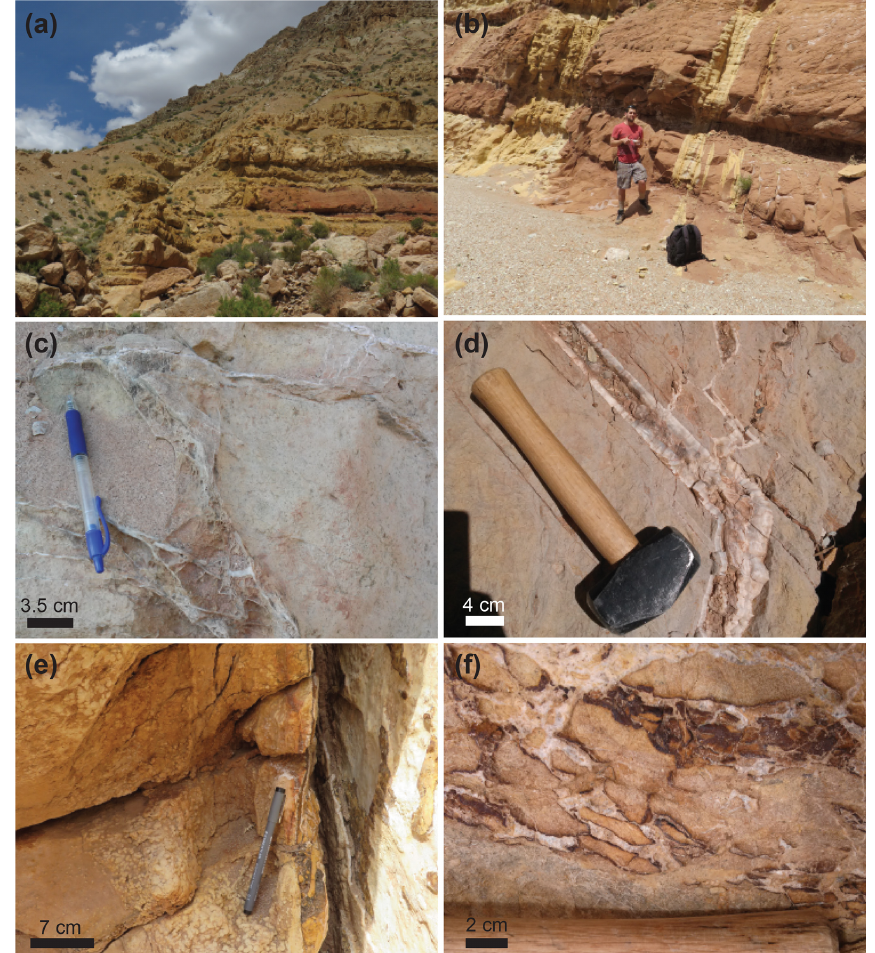
Figure 3. (a) Looking north along the Hurricane fault trace with colluvium in the hanging wall offset against the Permian Queantoweap Sandstone. Note the bleaching along the fault trace and in horizontal strata of the Queantoweap Sandstone. (b) Decimeter- to meter-scale bleached fractures cutting Queantoweap Sandstone (Jace Michael Koger used for scale). (c) Boxwork sparry calcite veins. (d) Laminated, centimeter-scale calcite vein with minor intergrown hematite cutting cherty limestone host rock. (e) Laminated calcite vein with minor hematite cutting Queantoweap Sandstone. Note the small calcite concretions cementing the sandstone parallel to the vein trace. (f) Calcite and hematite-cemented breccia in sandstone host